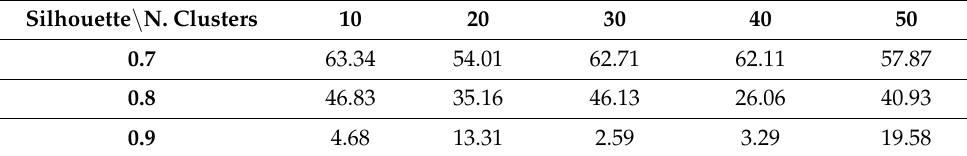
Table 9. Clustering performance in terms of silhouettes using the reduced dataset with SPQR. Silhouette \ N. Clusters